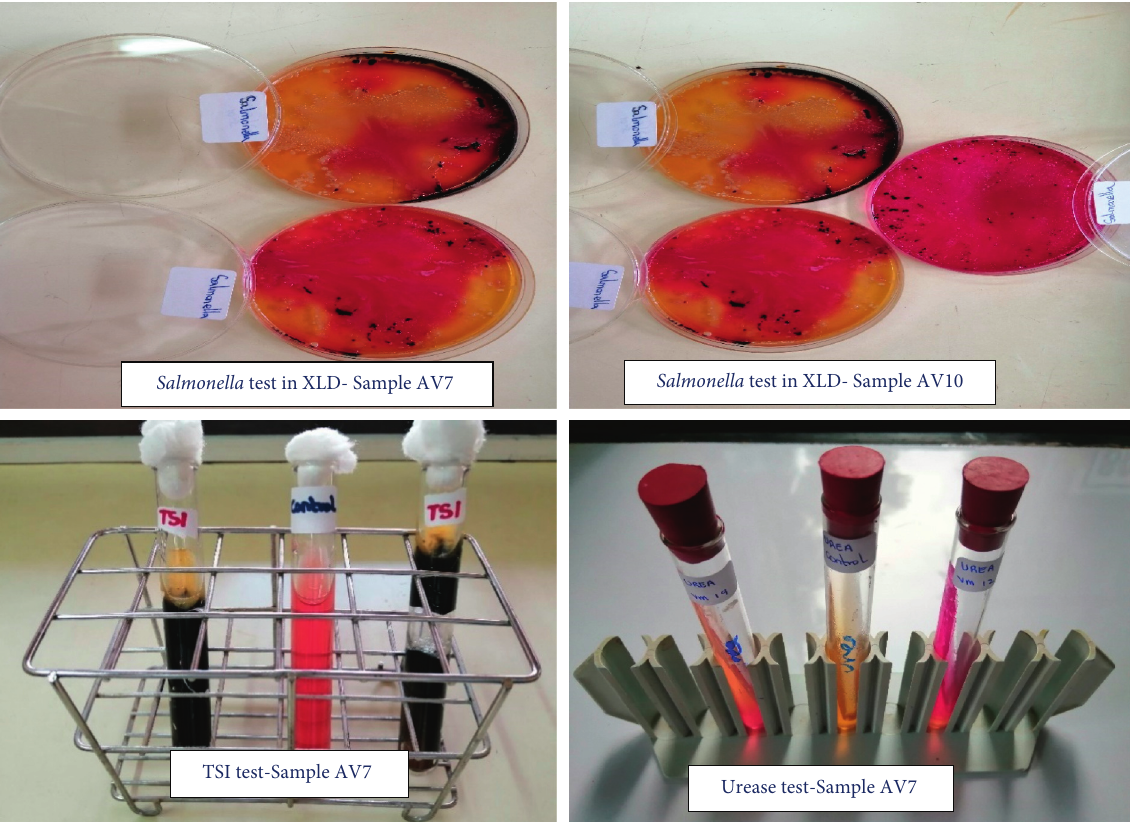
Figure 11: Characteristic colonies for Salmonella spp. on XLD agar and negative biochemical reactions on TSI and urea agar.